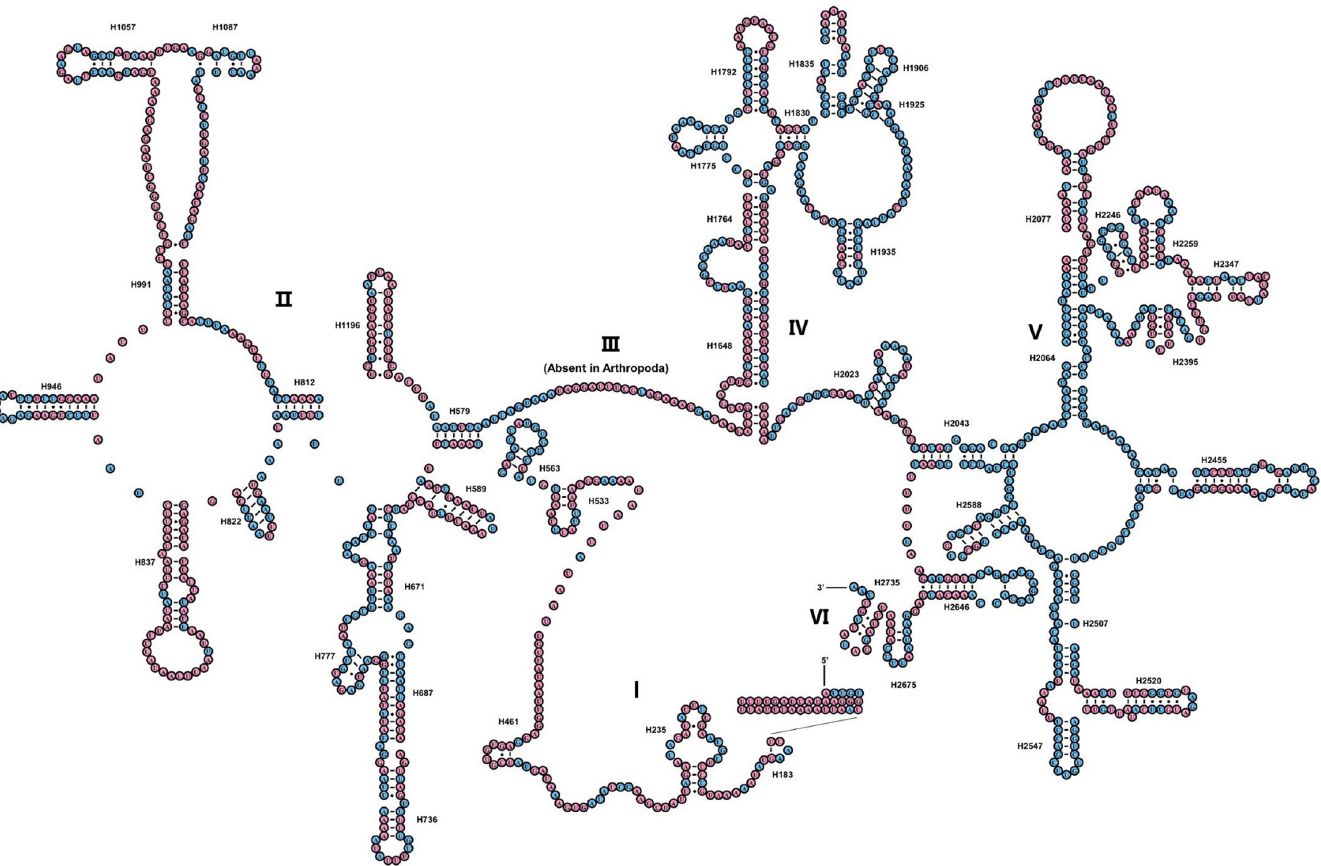
Fig 5. Inferred secondary structure of rrnL of Amorphoscelis chinensis . Inferred Watson-Crick bonds are illustrated by lines, whereas the noncanonical interactions are illustrated by dots.